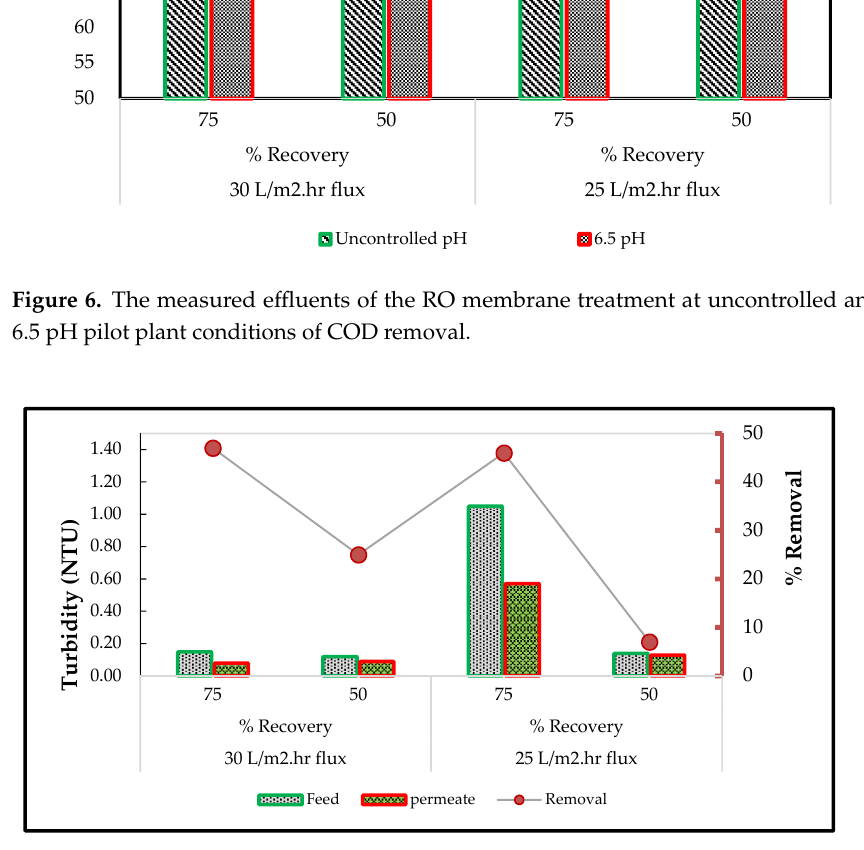
Figure 7. Turbidity removal using RO membrane with controlled pH at 6.5.